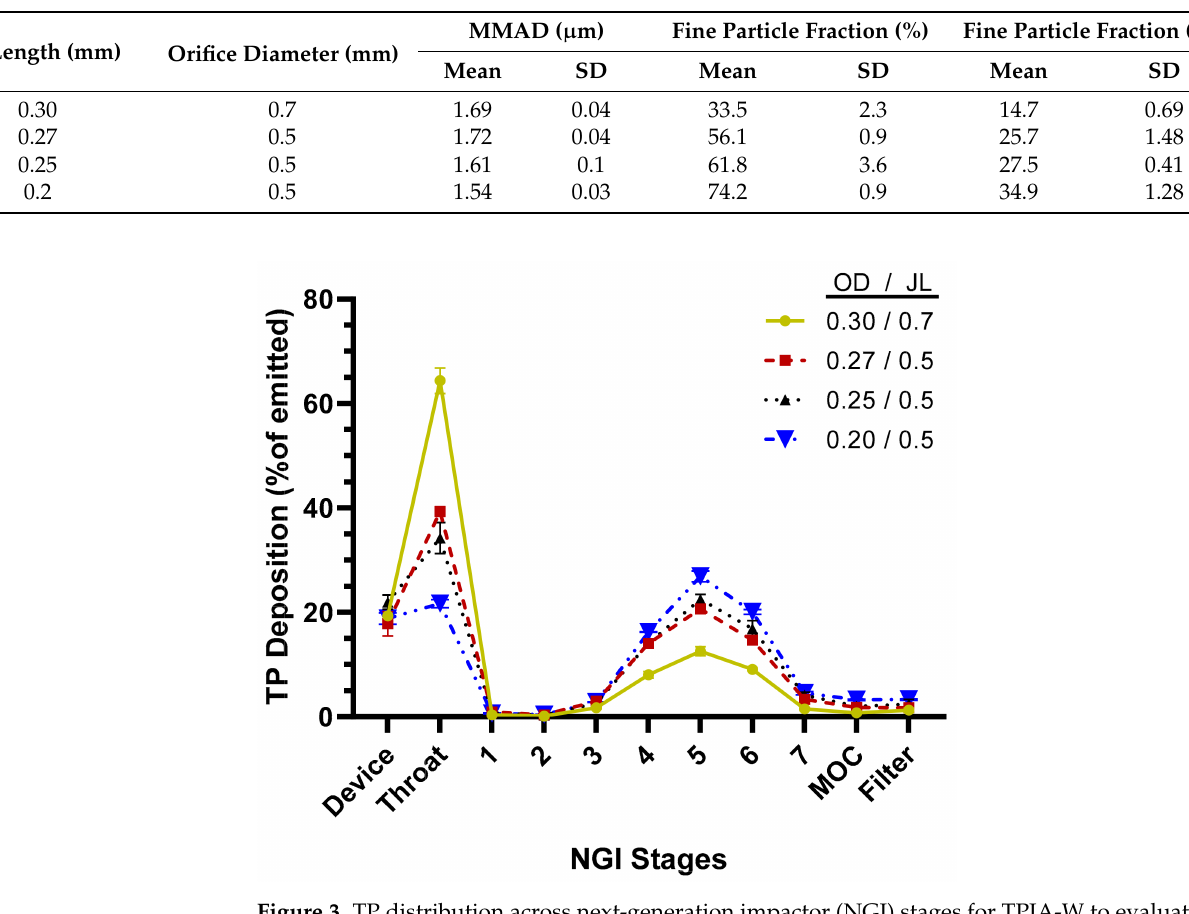
Table 2. Summary of aerodynamic particle size distribution (APSD) measurements for evaluating the effect of actuator configuration on TPIA-W aerosol performance.